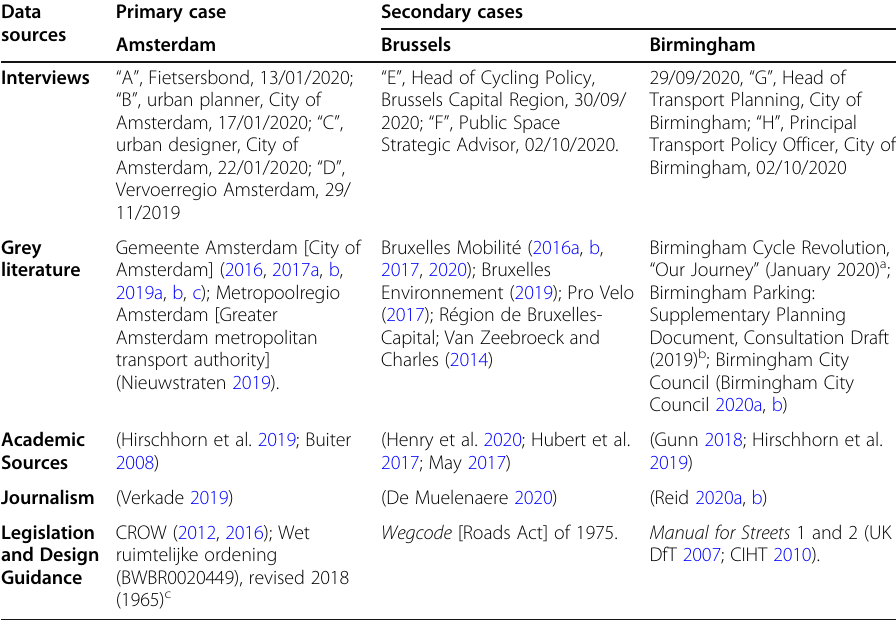
Table 4 Data sources for comparative case